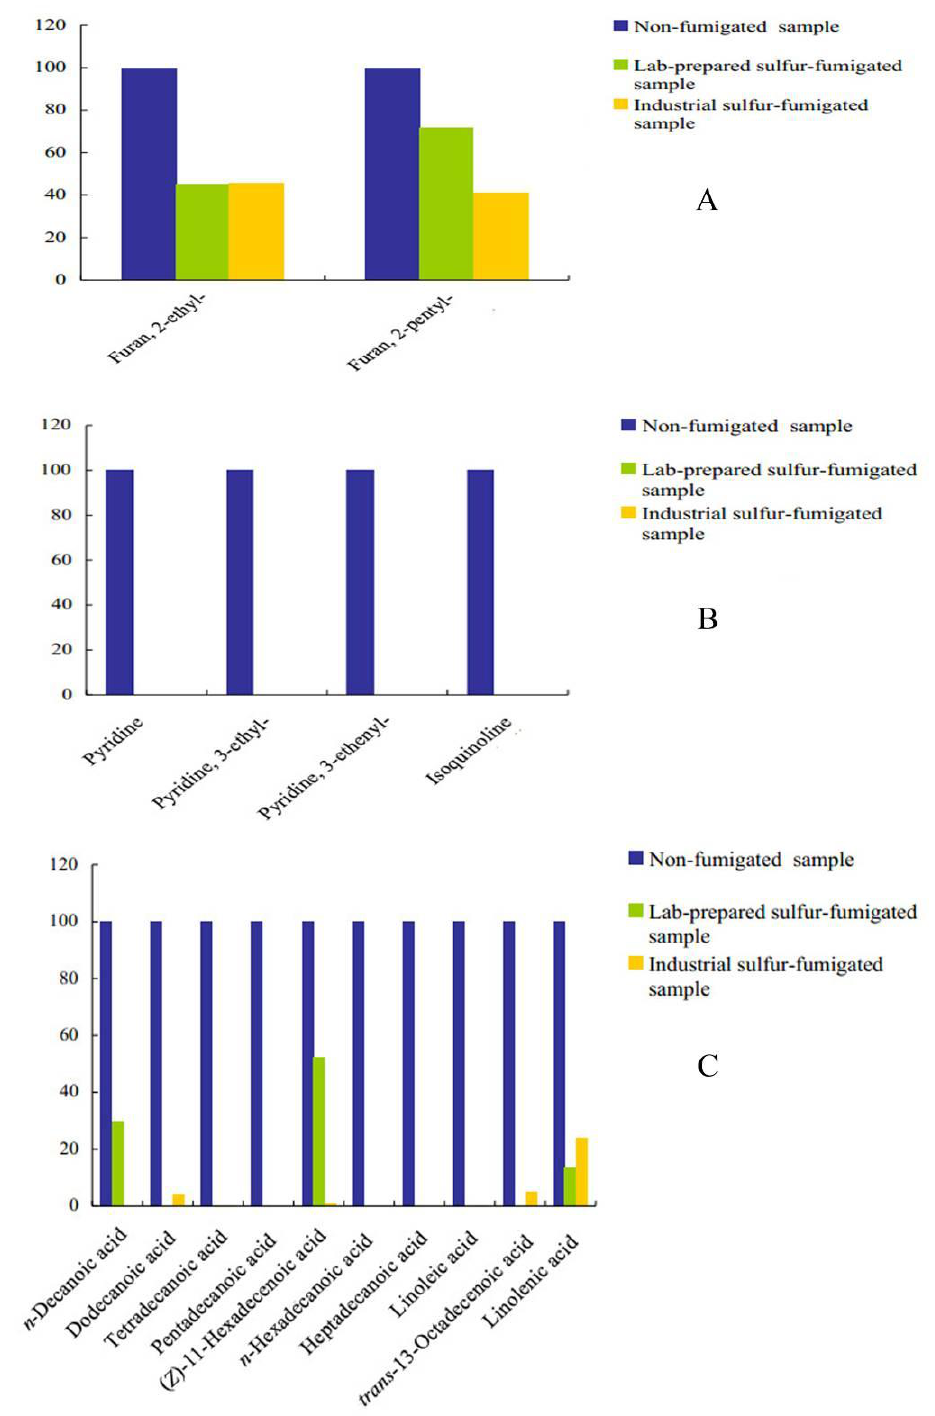
Figure 2. Comparison of the contents of major components in non-fumigated, lab-prepared sulfur-fumigated and industrial sulfur-fumigated Flos Lonicerae Japonicae volatile oils. ( A ) Furans, ( B ) Alkalies, ( C ) Acids, ( D ) Aldehydes, ( E ) Ketones, ( F ) Alcohols, ( G ) Terpenes, ( H ) Esters and ( I )